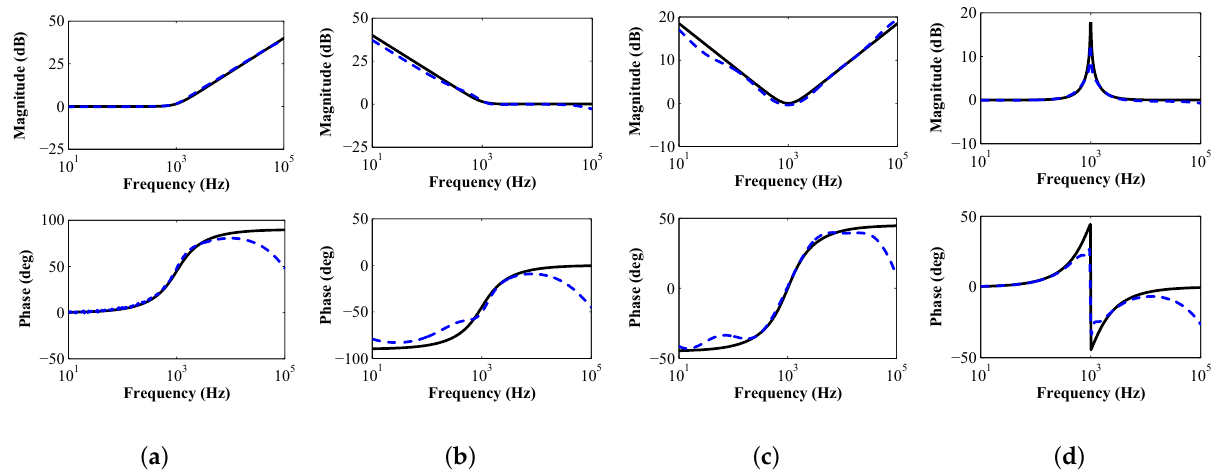
Figure 15. Comparisons between the theoretical (solid black) and experimentally (dashed blue) obtained ( a ) LP, ( b ) HP, ( c ) BP, and ( d ) BS filter frequency responses of the IPLFs ( α = 0.5 ) .